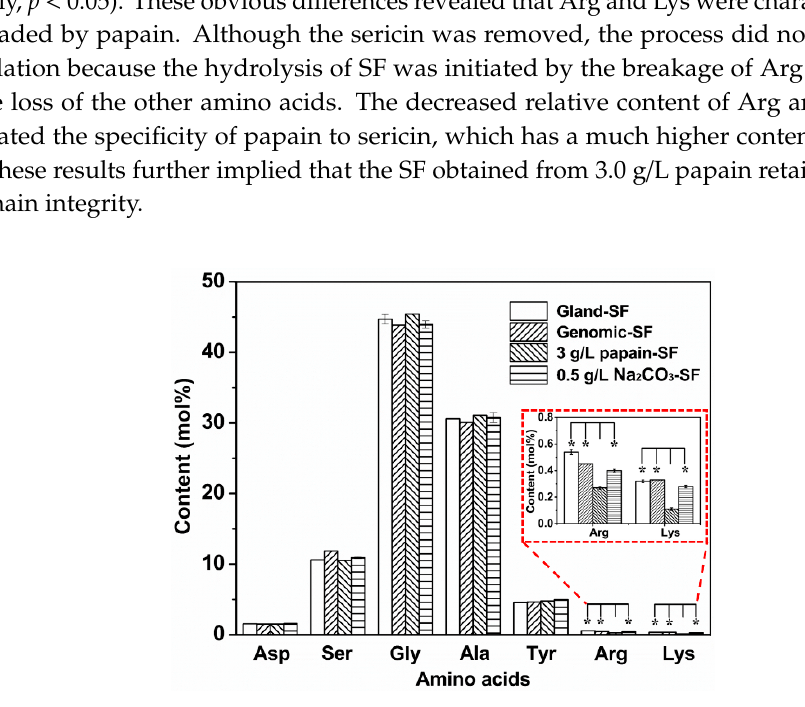
Figure 6. ( a-1 ) and ( a-2 ) SDS-PAGE patterns of regenerated SF derived from different degumming methods. ( M ) Molecular weight marker, ( A ) Na 2 CO 3 -SF, ( B ) 3.0 g/L papain-SF. Separating gel concentration: ( a-1 ) 15%, ( a-2 ) 6%. ( b ) Semi-quantitative statistics of molecular weight distributions (MWDs) based on SDS-PAGE patterns.